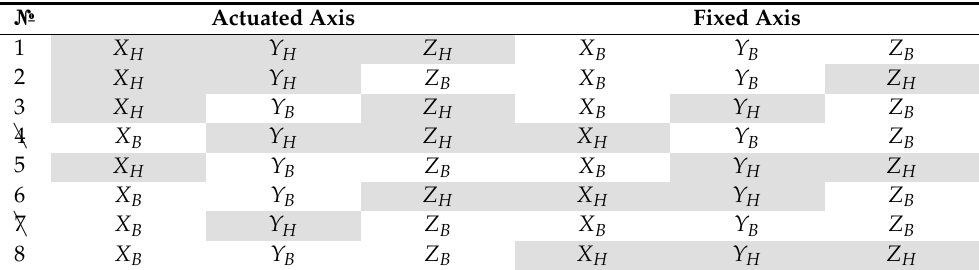
Table A1. Variability in axis mobility of the Cartesian 3D printer. Cells for the printhead are filled gray. Rows 4 and 7 are not investigated further.